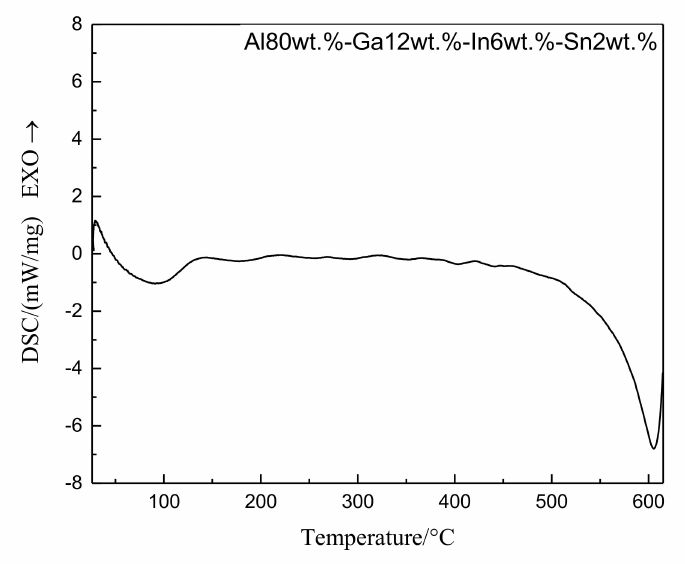
Figure 7. Temperature rise curve of differential scanning calorimetry (DSC) of alloy samples.